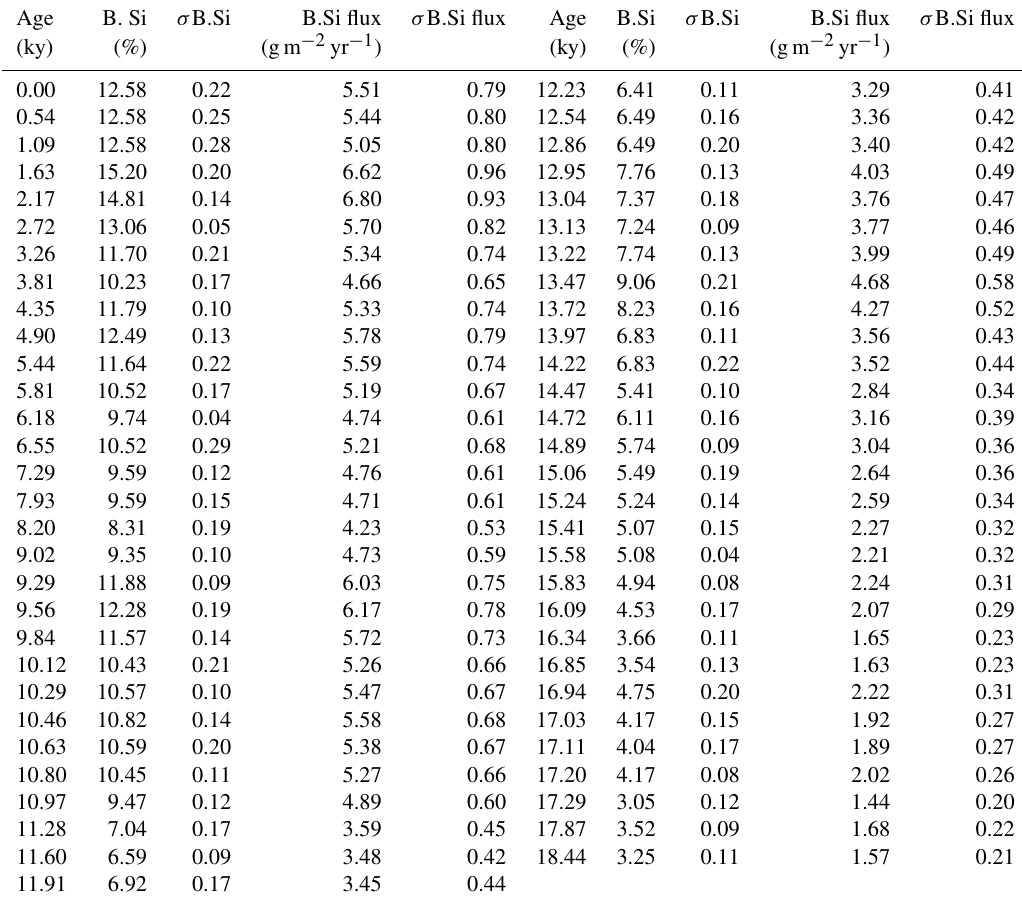
Figure 5. Temporal variation of the biogenic silica flux with 2 σ uncertainty in the SS-4018 sediment core. Filled triangles at the bottom of the plot marks the age-control points with 1 σ uncertainty. Table 1. Biogenic silica concentration and flux